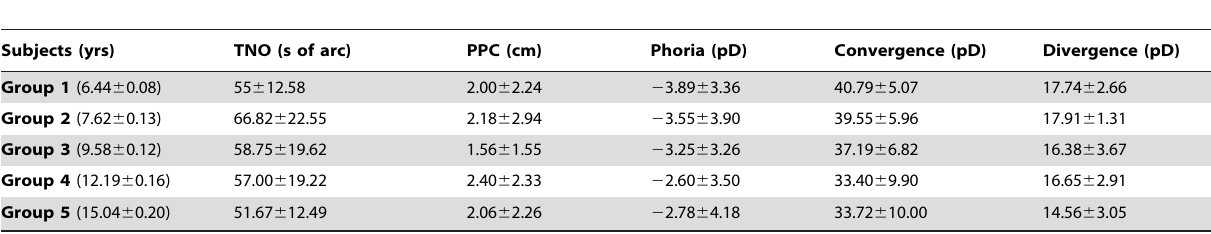
Table 2. Clinical characteristics of the five groups of children examined.